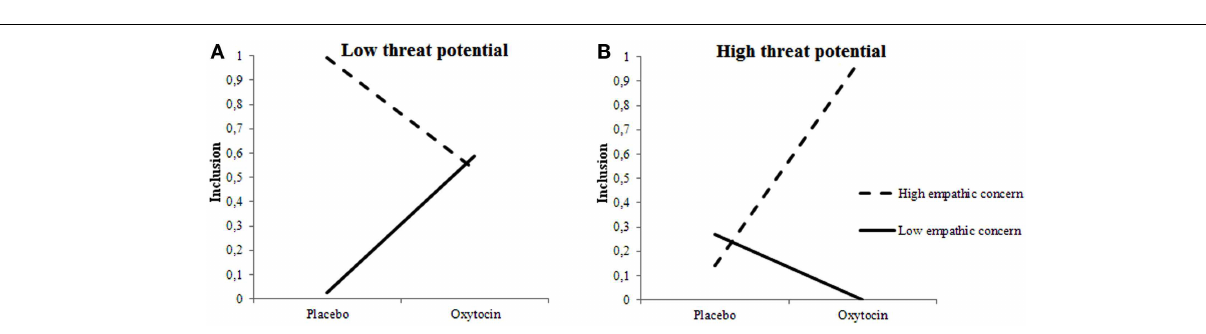
FIGURE 2 | Empathic concern moderates effects of oxytocin on inclusion decisions. Low-threat targets (A) are preferred less and high-threat targets (B) are preferred more by individuals with high empathic concern when given oxytocin rather than placebo.